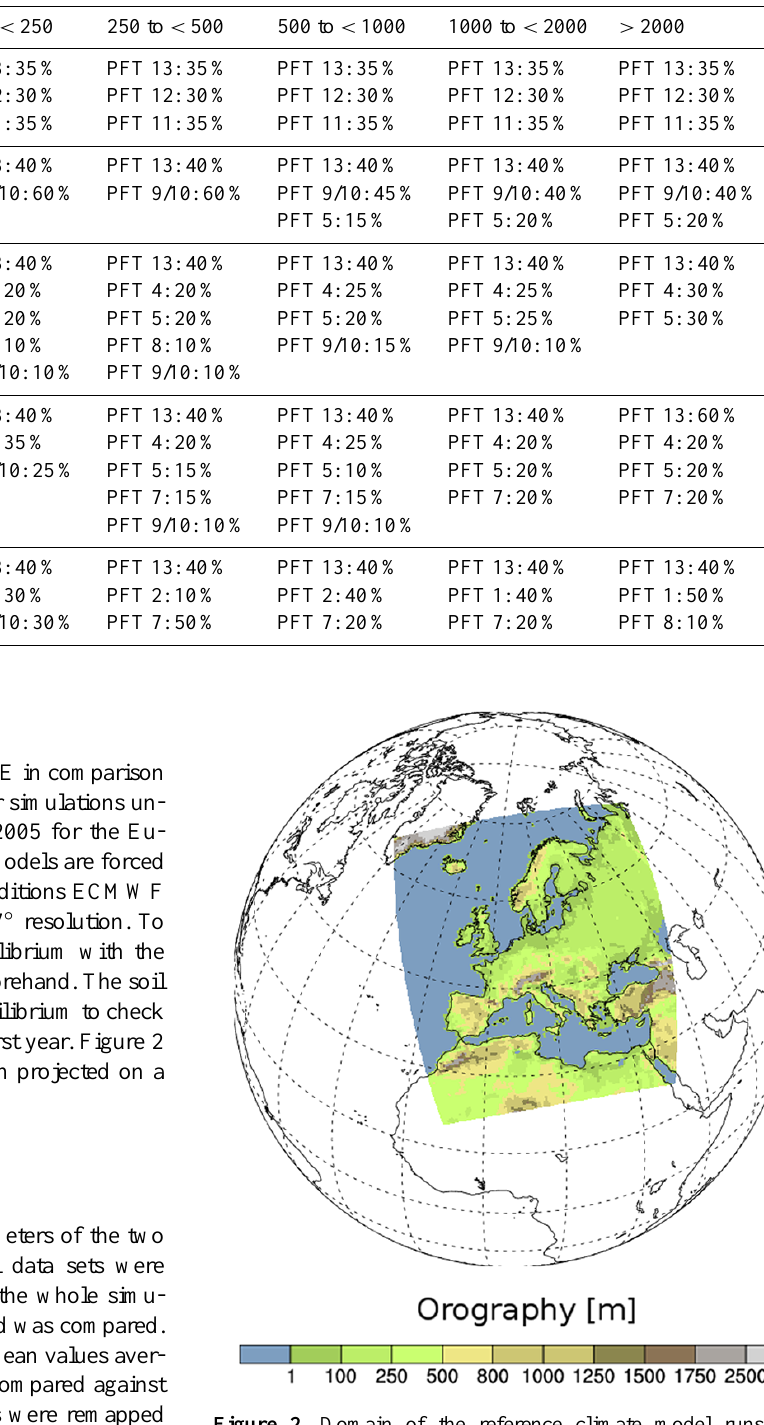
Figure 2. Domain of the reference climate model runs with REMO2009 and